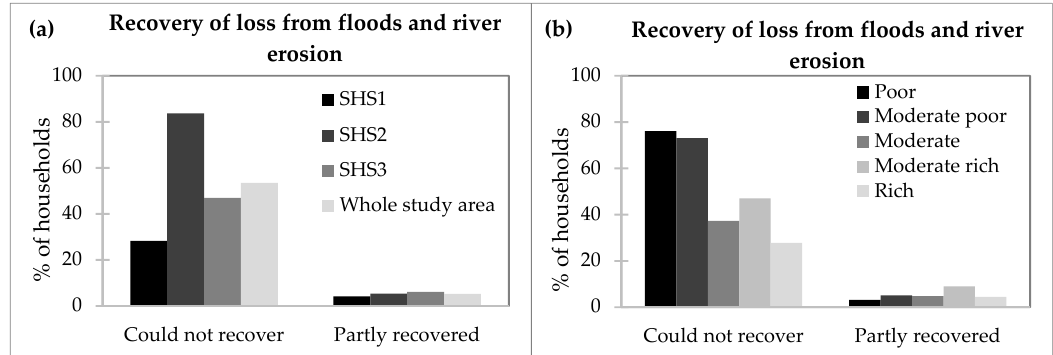
Figure 8. Recovery of loss from floods and riverbank erosion in the study area. ( a ) Recovery of loss from floods and river erosion; ( b ) Recovery of loss from floods and river erosion.